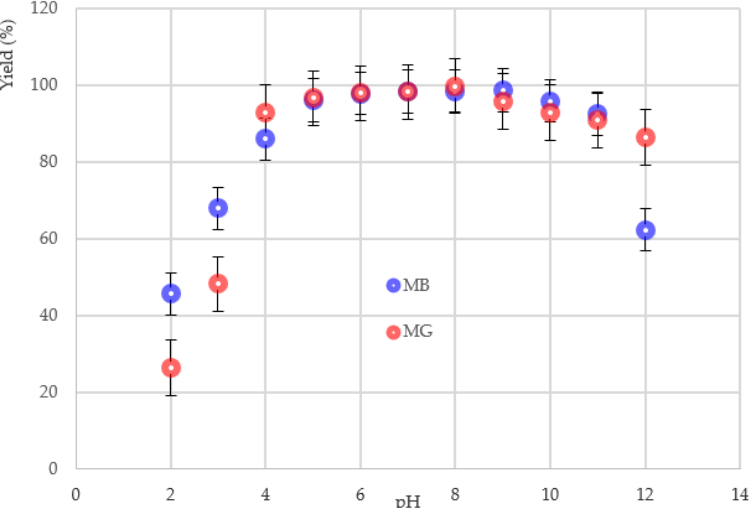
Figure 7. Effect of pH on the removal of MB and MG by 4AZW from aqueous solution. (C 0 (MB) = 11.5 mg/L, C 0 (MG) = 45 mg/L, S/L = 1 g/L, contact time 70 min, T = 25 ± 1 °C).